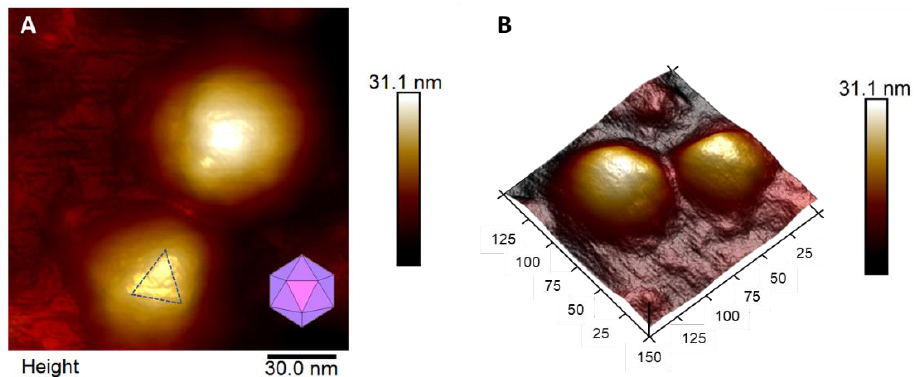
Figure 2. Adsorption patterns. ( A ) Height image of two VPs. Different adsorption patterns evidence the icosahedral geometry of the virus. ( B ) Three-dimensional visualization of image ( A ). The blue dotted triangle highlights the relationship with the inset image, representing virus ’ icosahedral geometry.